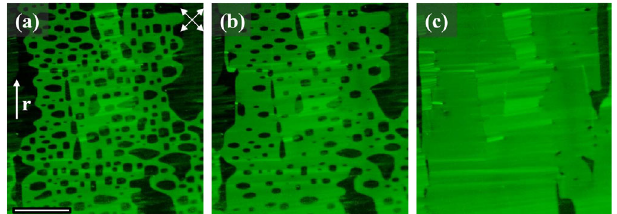
FIG. 21. Biphasic coexistence of the M (bright) and N X TB (dark) phases in a d ¼ 1 . 4 μ m planar-alignment cell at different temperatures: 100 °C (a), 98 °C (b), and 97 °C (c). To visualize the different birefringence of the two phases, the cell is observed under polarized monochromatic light ( λ ¼ 546 nm) with a S´enarmont compensator and with an analyzer rotated by an angle optimizing the contrast between the two phases. Each image is recorded after 15 min of relaxation at fixed temperature to reach equilibrium between the two phases. (Scale bar 100 μ